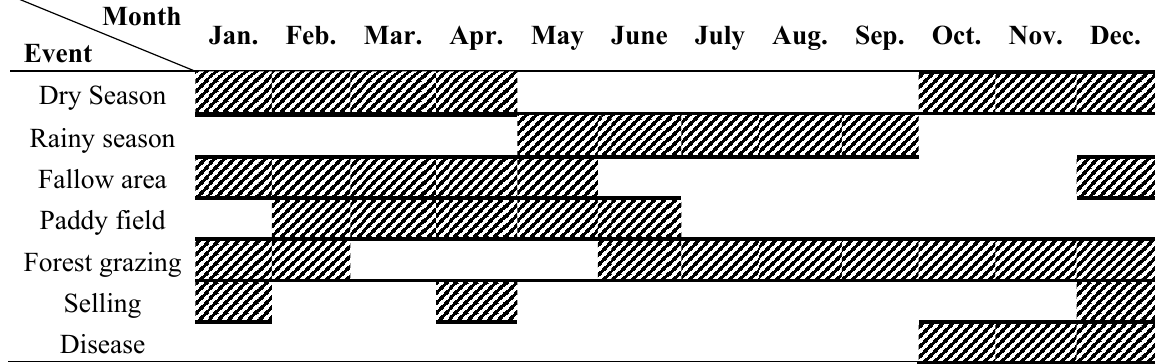
Figure 4. Events relevant for animal husbandry practices along the seasons. Source: Seasonal calendar elaborated in a participatory group discussion in Viengphathana